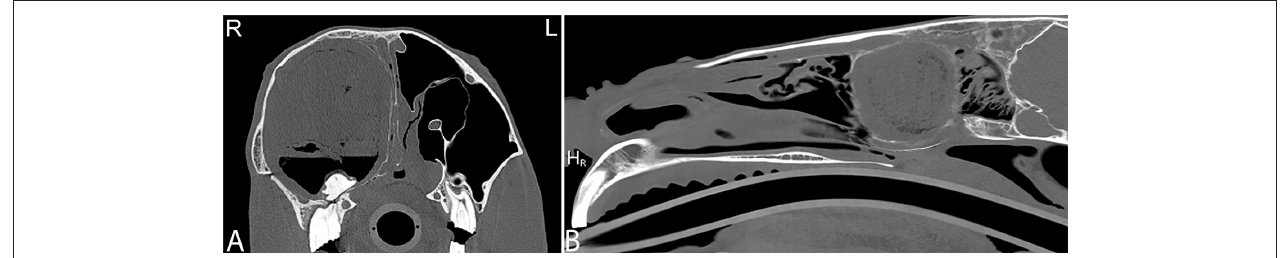
FIGURE 11 | Large sinus cyst with maxillary distortion. Transverse and sagittal computed tomography images of the head of a 20-year-old Thoroughbred gelding with a history of facial swelling. In the transverse (A) and sagittal (B) bone window CT images of the mid-aspect of the skull, a large mixed attenuation, round, well-defined structure surrounded by a thin rim of mineral attenuating material with deformity of the right maxilla and ethmoid bone is noted. L, left; R, right.